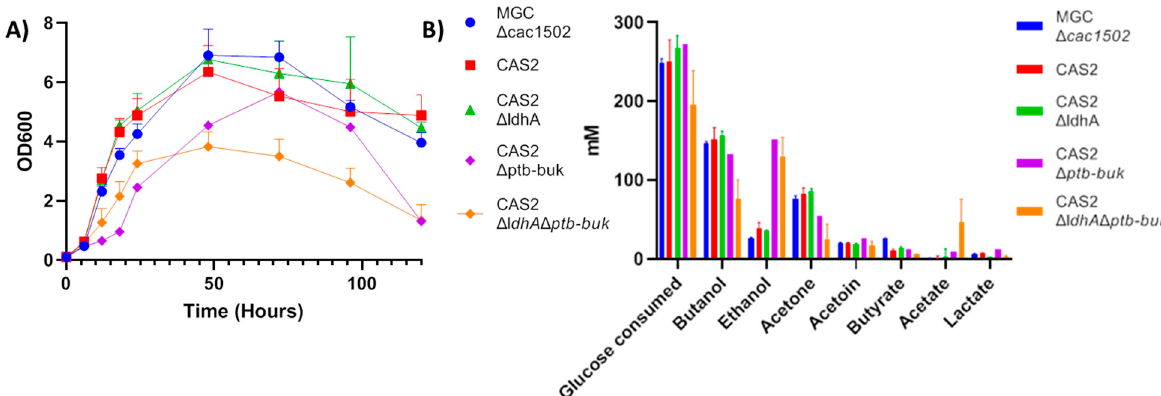
Figure 4. Growth curve and product analysis of recombinant strains. ( A ) Growth curve of strains MGC Δ cac1502 , CAS2, CAS2 Δ ldhA, CAS2 Δ ptb-buk , and CAS2 Δ l dhA Δ ptb-buk in batch culture in synthetic medium (MS) . ( B ) Solvent and acid production of MGC Δ cac1502 , CAS2, CAS2 Δ ldhA , CAS2 Δ ptb-buk , and CAS2 Δ l dhA Δ ptb-buk in batch culture in MS medi-